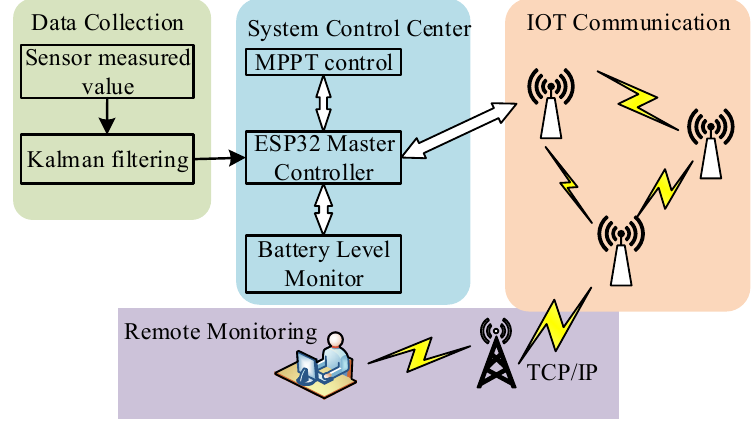
Figure 10. General block diagram of MPPT control system.